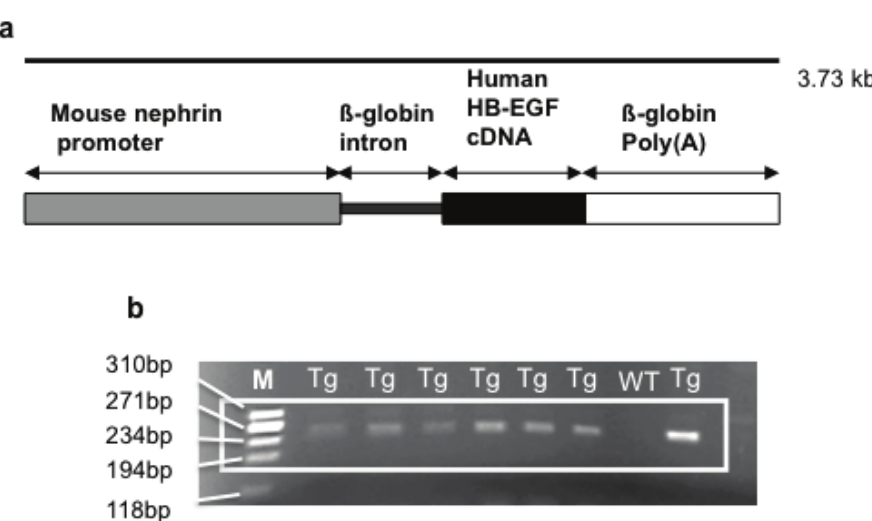
Figure 1. ( a ) Schematic representation of the transgene. Human diphtheria toxin receptor (DTR), or human heparin binding-epidermal growth factor (HB-EGF) receptor, is expressed as a transgene under the control of the murine nephrin promoter. ( b ) Agarose gel showing positive bands for the PCR products of a 243bp fragment from podocyte nephrin promoter and rabbit-ß-globin intron of transgenic Podo-DTR mice. M, marker Hae ladder; Tg , trasgenic; WT , wild